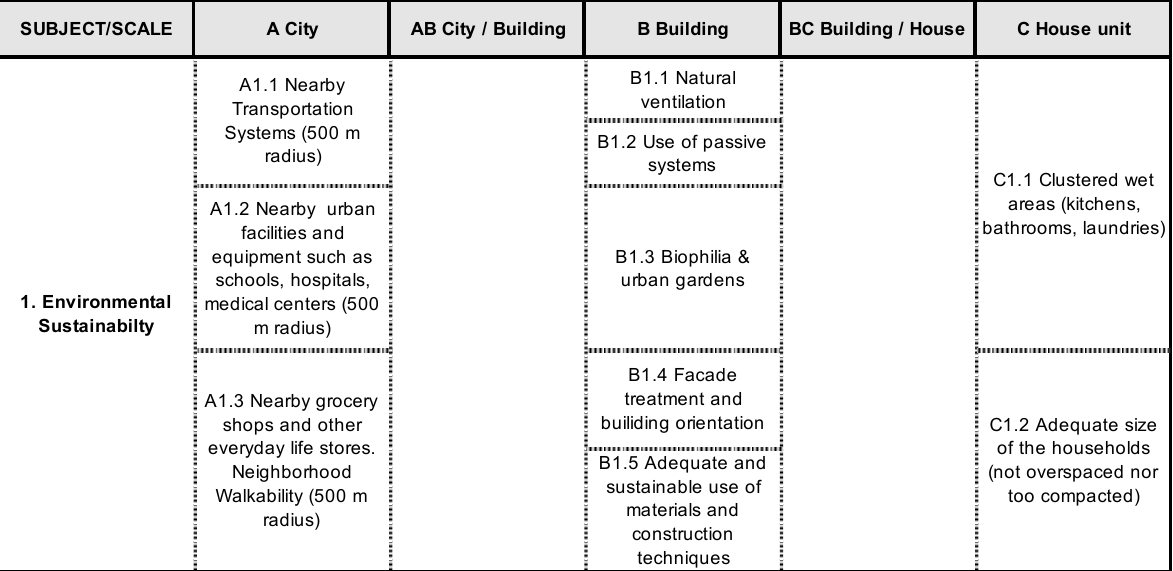
Figure 1. Environmental Sustainability Indicators. Source own elaboration.